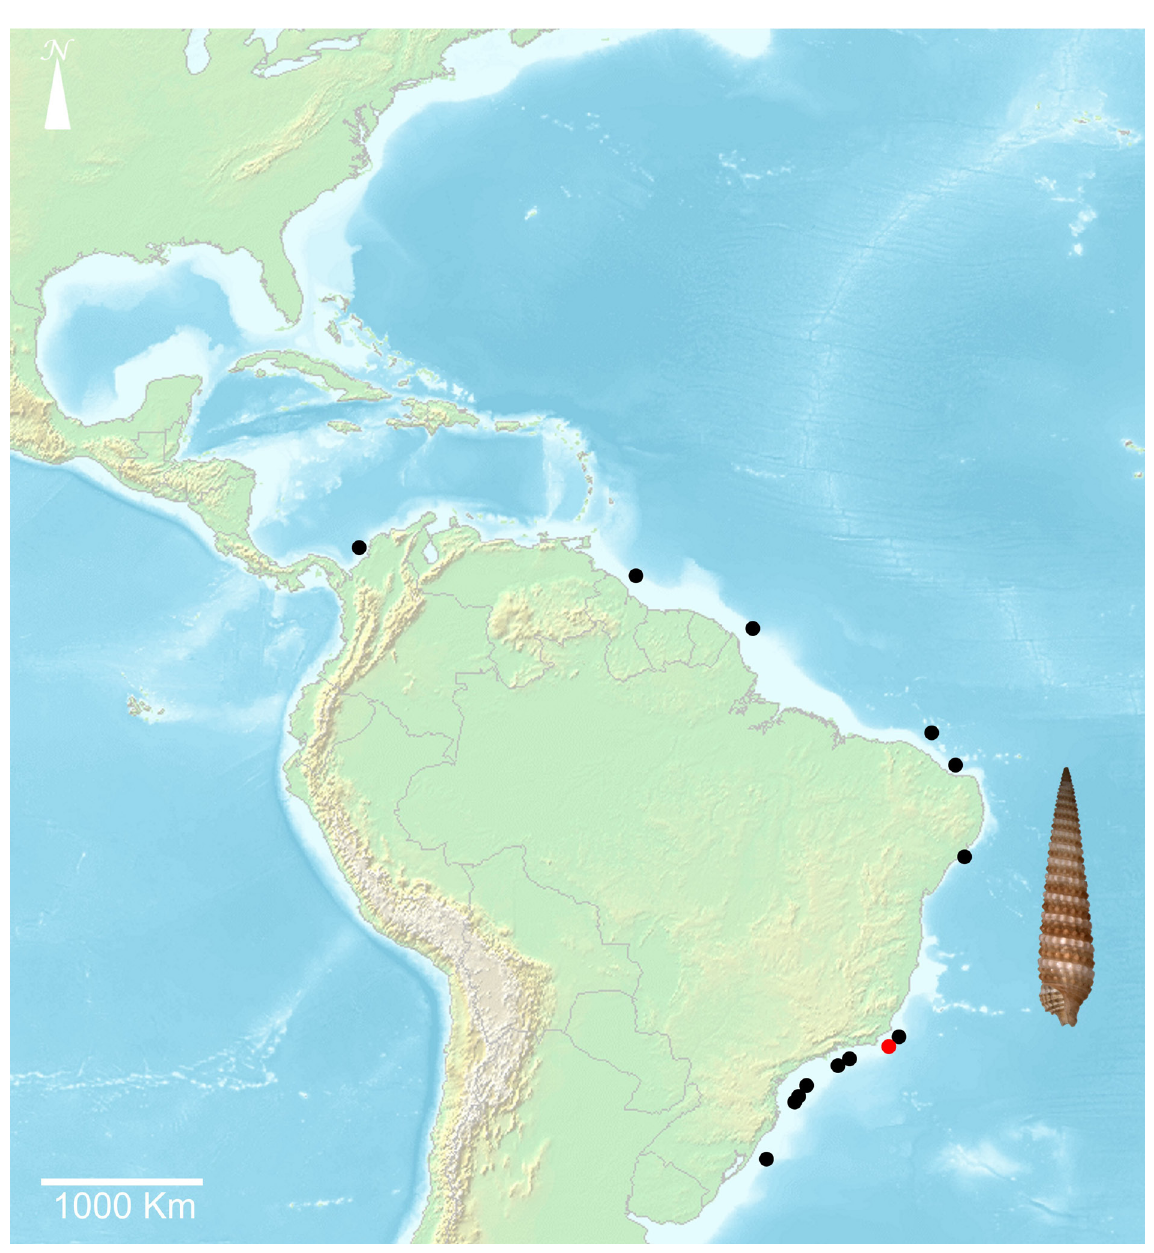
Fig. 77. Distribution map of Triphora charybdis Fernandes & Pimenta, 2015; red circle = type